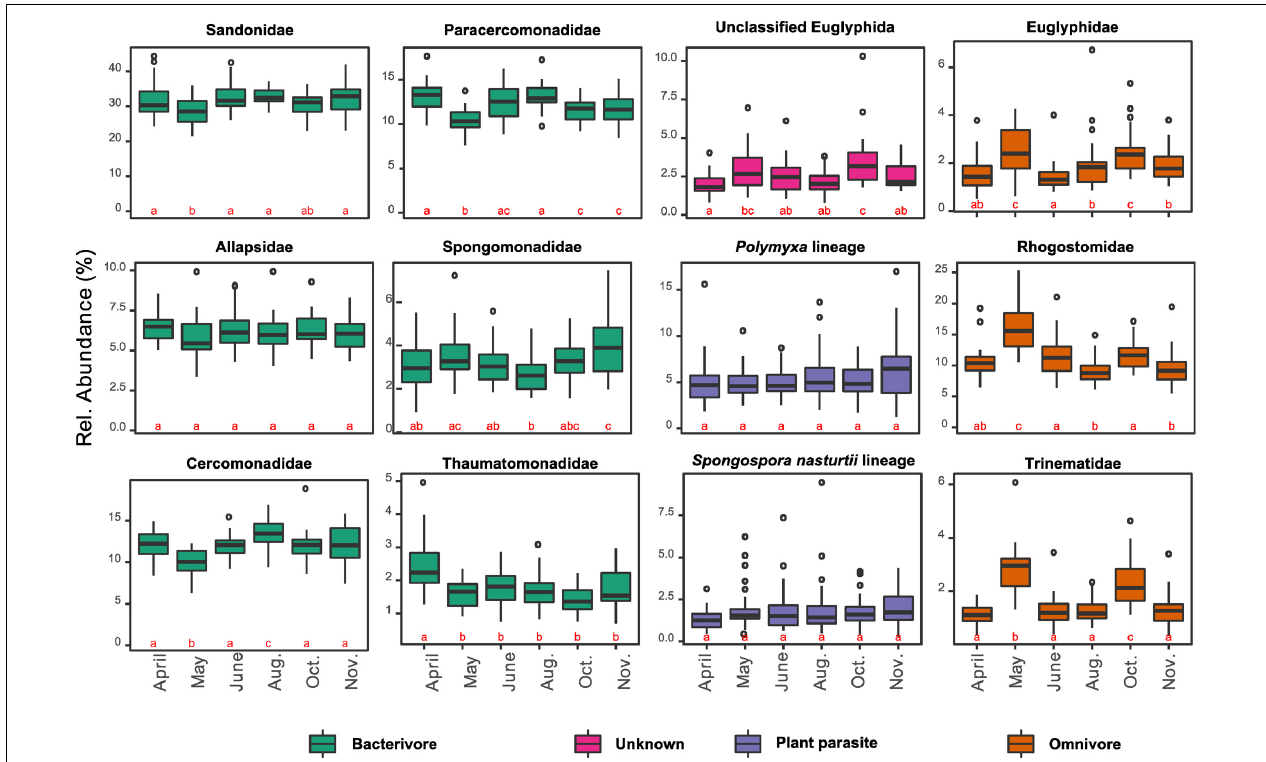
FIGURE 4 | Box plots of the seasonal variation in the relative abundance of the 12 most abundant cercozoan families characterized by their nutrition mode (in different colors). Note that the y -scale varies between graphs. The small letters a, b, and c designate statistically significant differences in abundance between sampling dates (contrasts of estimated marginal means on generalized least squares models after correction for spatial autocorrelation). A change of letter from “a” to “b”, or “c” indicates a significant difference between sampling dates; “ab” indicate non-significant differences between dates sharing those